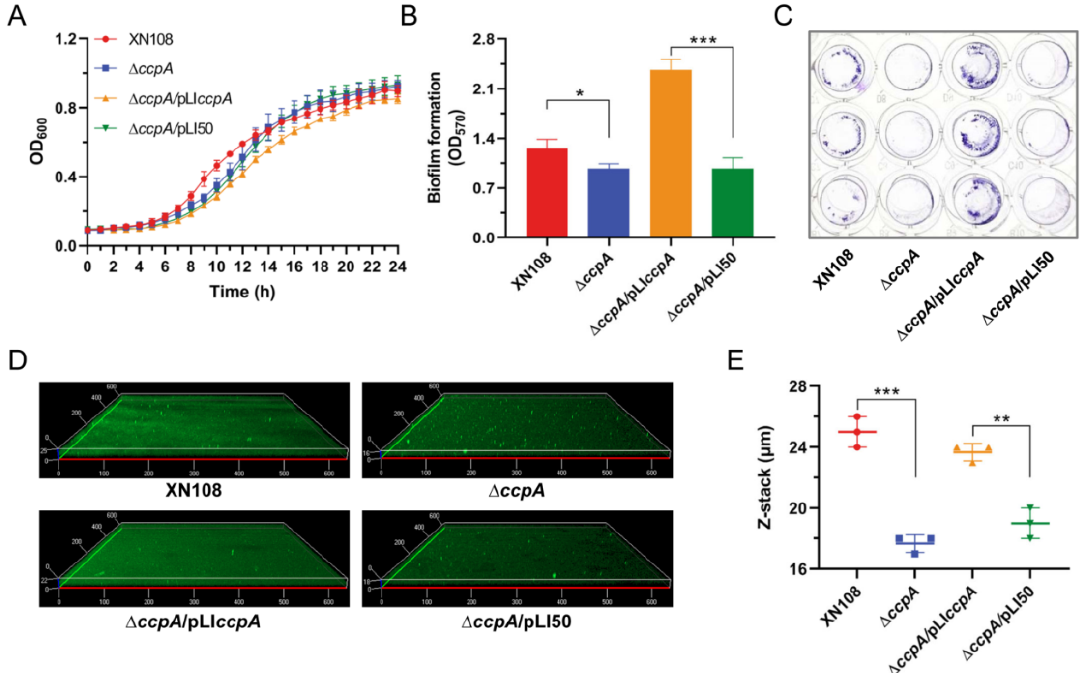
Figure 1. Impact of ccpA deletion on growth and biofilm formation of S. aureus strain XN108. ( A ) Profiling of bacterial growth. S. aureus strain XN108 and derivatives differing in ccpA expression were cultivated in TSB medium in triplicate at 37 °C for 24 h. Optical density at 600 nm (OD 600 ) was recorded every one hour to probe bacterial growth. ( B ) Biofilm formation assessment. Biofilms were cultured in TSB + G medium under static conditions for 24 h, and quantified via crystal violet staining. The data are expressed as the mean ± SD (standard deviation) from three independent experiments. *, p < 0.05, ***, p < 0.001. ( C ) Representative images of biofilm crystal violet staining from ( B , D ) CLSM of biofilm formation. Biofilms were cultured in TSB + G medium under static conditions for 24 h, stained with FITC-ConA and propidium iodide (PI), and visualized by CLSM. Representative images from three independent replicates were shown. ( E ) Statistics of the biofilm thickness from ( D ) The data are expressed as the mean ± SD from three independent ex- periments. **, p < 0.01, ***, p < 0.001.